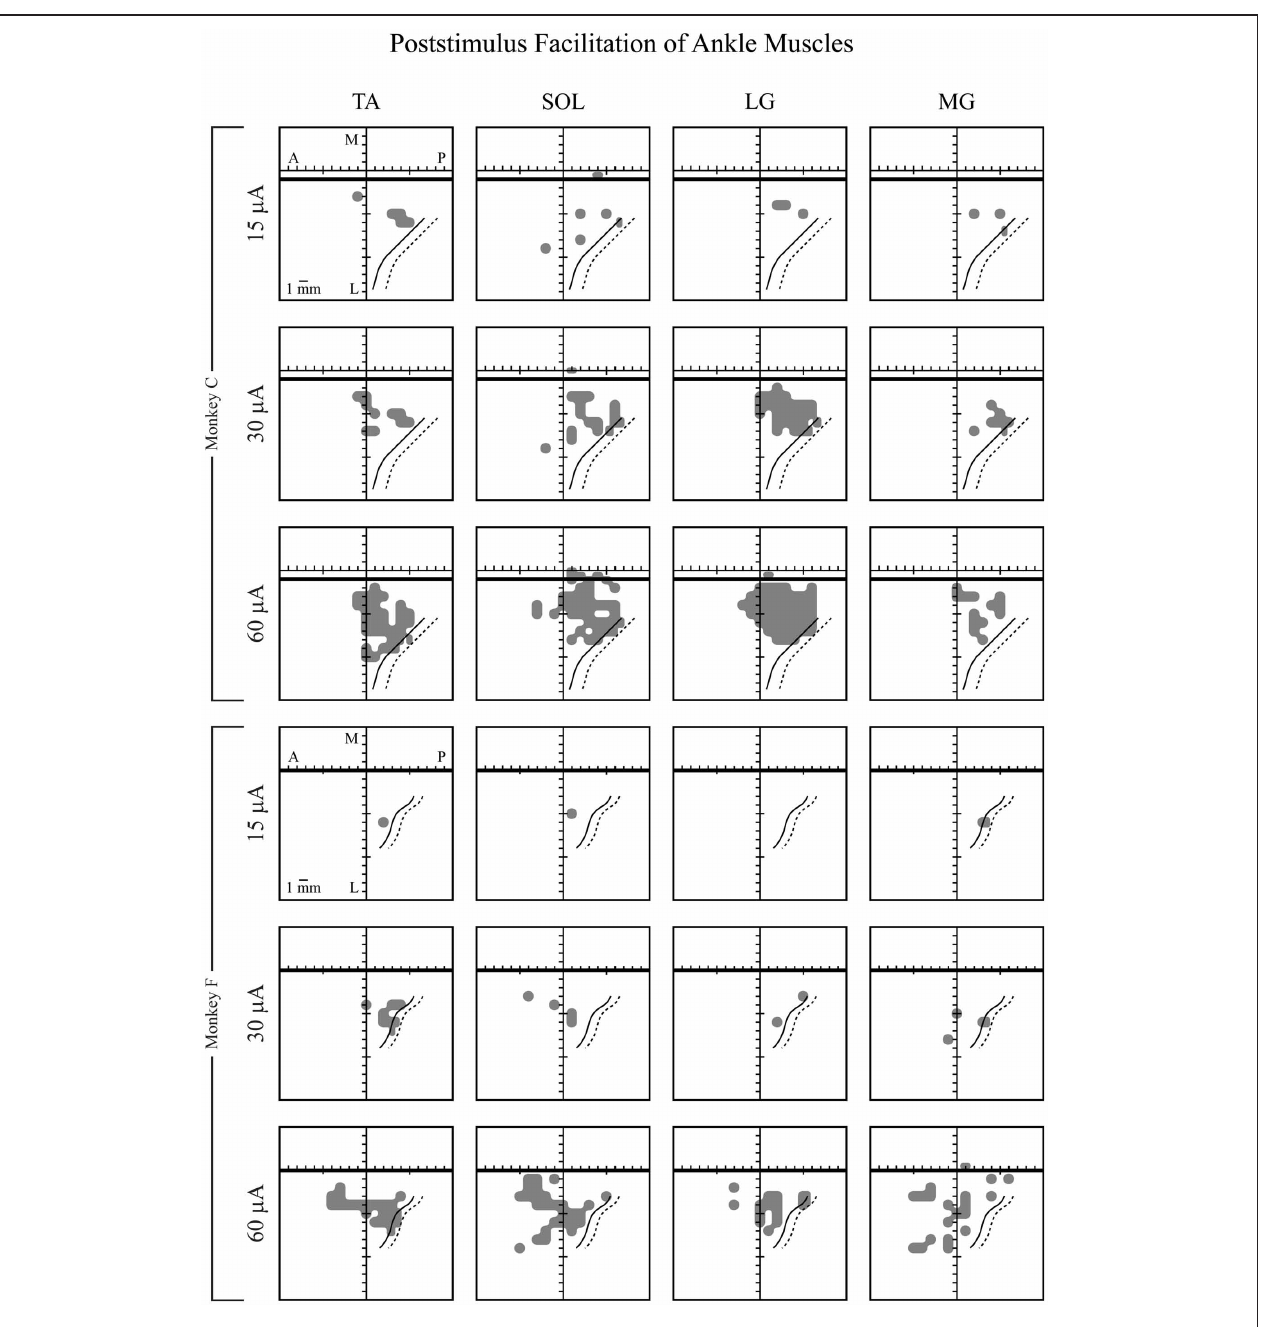
FIGURE 6 | Maps of individual ankle muscle representations in hindlimb primary motor cortex in two monkeys (F and C), represented in two dimensions after unfolding the medial wall and central sulcus. Maps of hindlimb muscles were based on PStF effects at 15, 30, and 60 µ A. Heavy